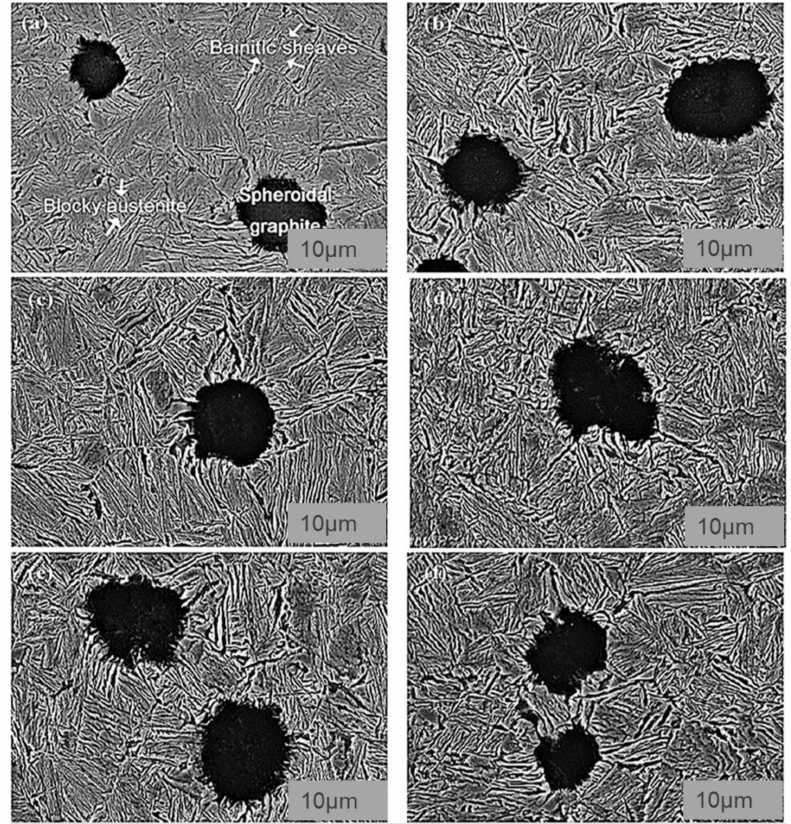
Figure 17. Morphological structures of austempered ductile iron specimens after partitioning at ( a ) 200 ◦ C for 10 min, ( b ) 300 ◦ C for 10 min, ( c ) 200 ◦ C for 30 min, ( d ) 300 ◦ C for 30 min, ( e ) 200 ◦ C for 60 min, and ( f ) 300 ◦ C for 60 min